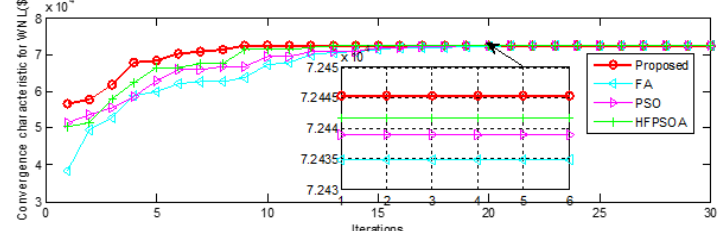
Figure 9. The convergence characteristic for the WNL.